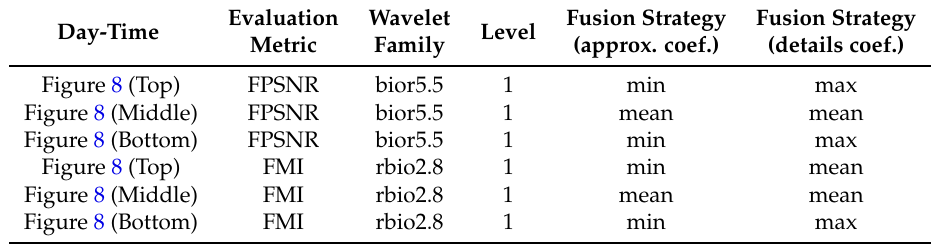
Figure 8. Three pairs of cross-spectral images of the same scene but at different day-time (images from [8]): ( Left ) VS; ( Right ) LWIR. Table 4. Best setups according to the evaluation metric for the pair of cross-spectral images presented in Figure